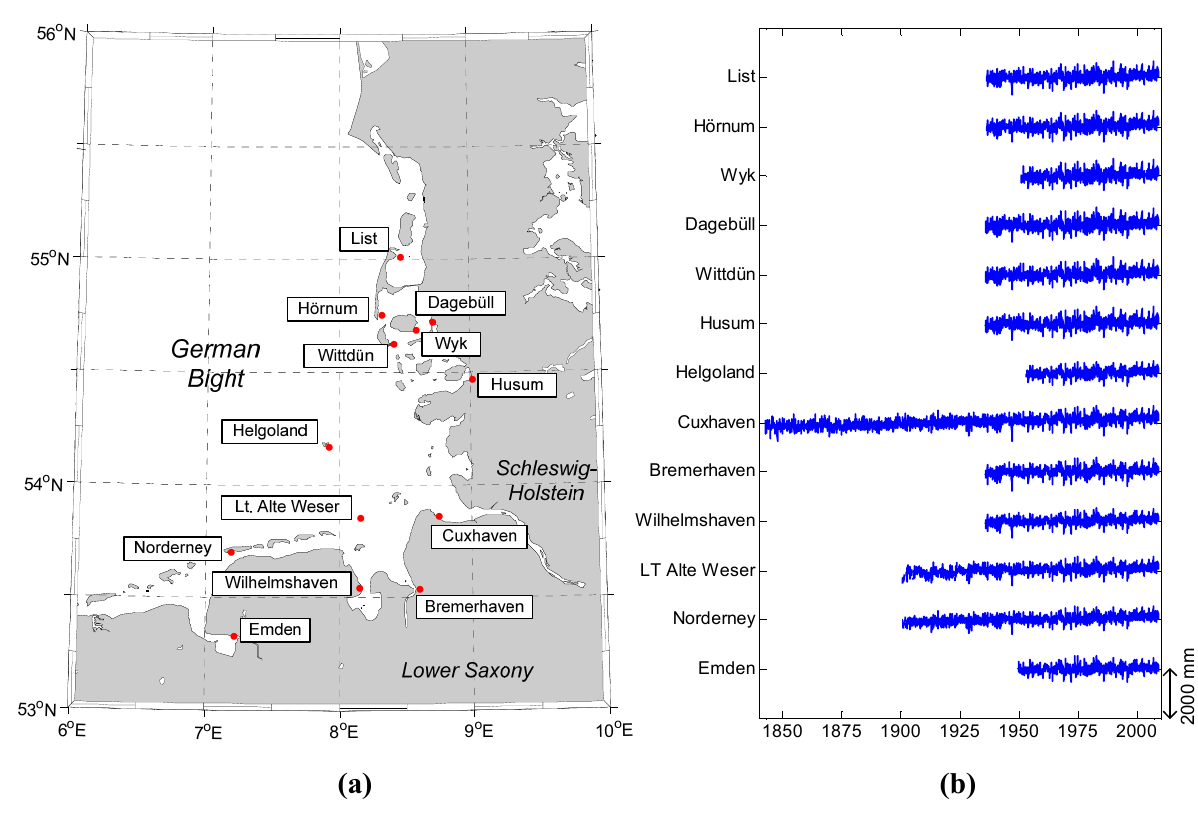
Figure 1. Investigation area with the location of analyzed gauges ( a ) and the monthly MSL time series of the single records ( b